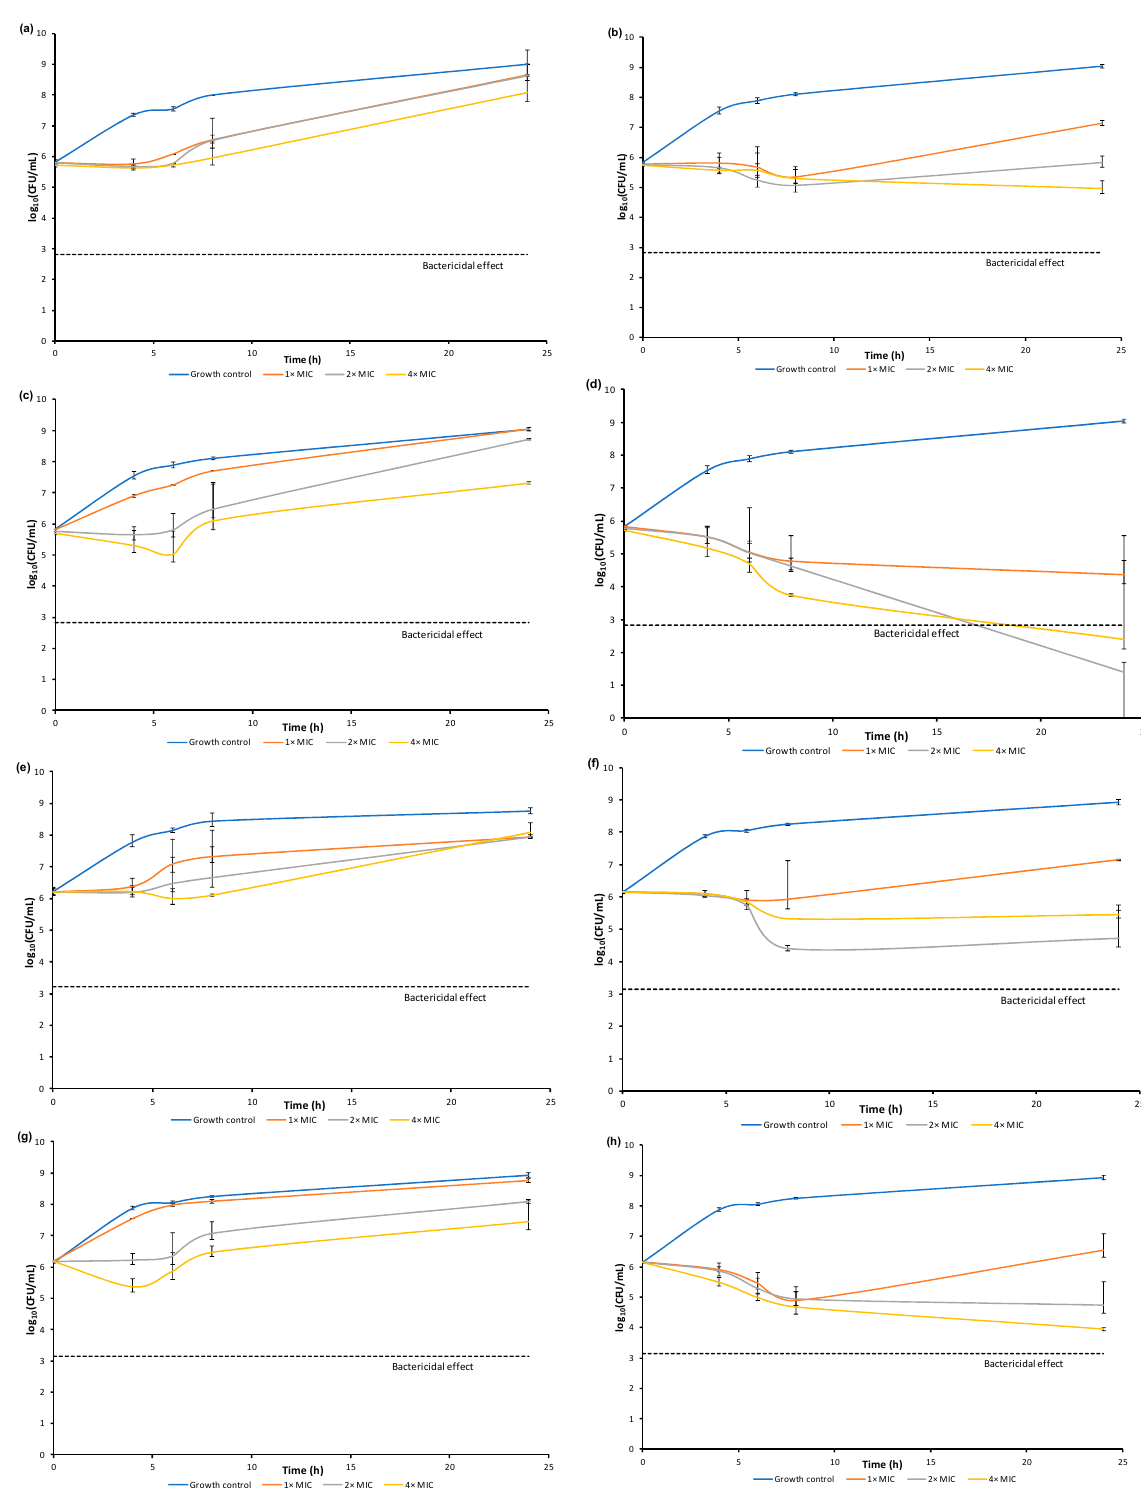
Figure 6. Comparison of dynamics of antibacterial activity of selected compounds 16 , 17 , 20 , 21 against S. aureus ATCC 29213 ( a – d ) and MRSA SA 3202 ( e – h ).